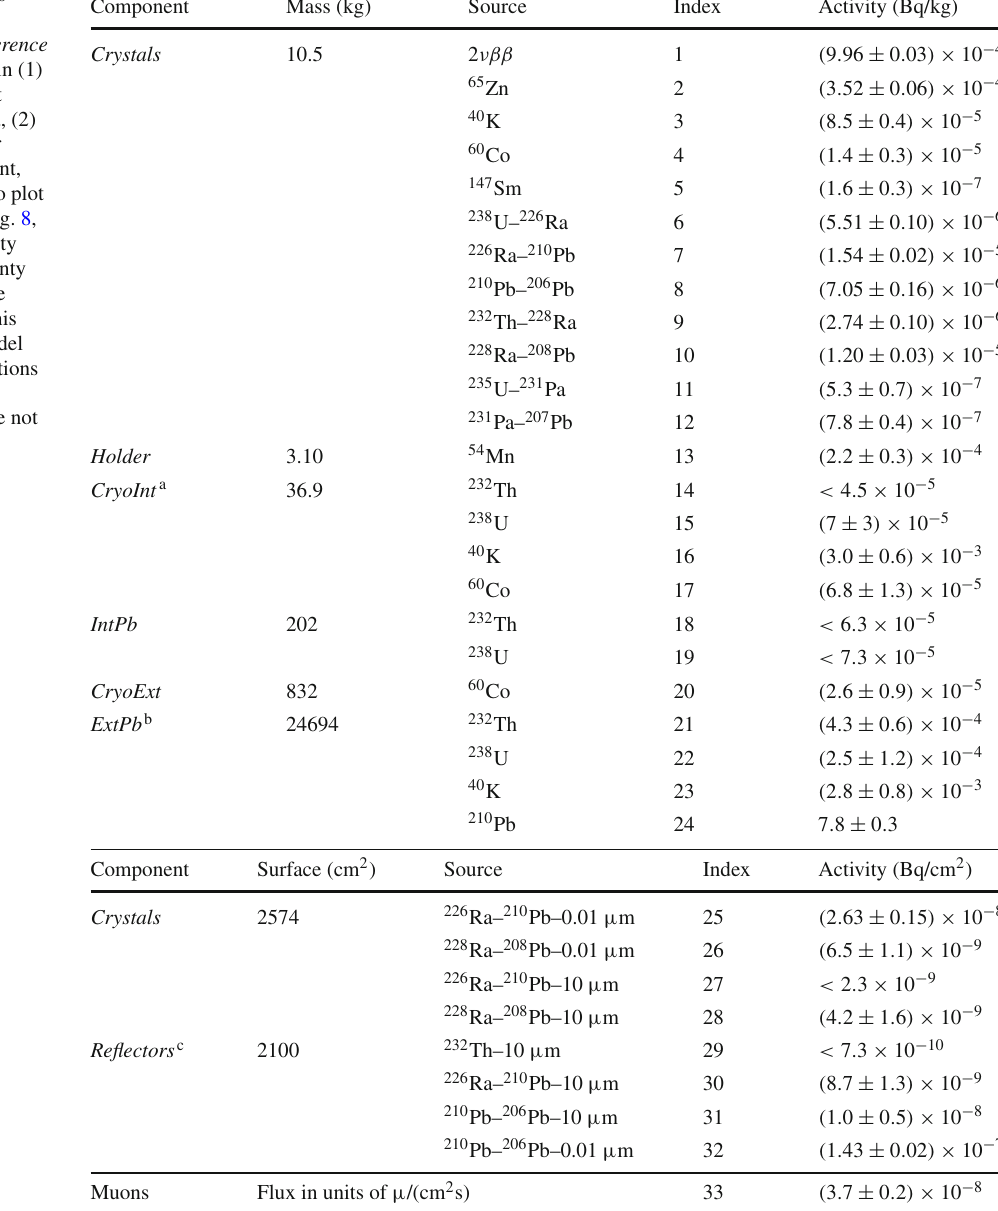
Table 4 List of the sources used to fit the CUPID-0 background data in the reference model. The columns contain (1) the name of the component where the source is located, (2) the corresponding mass (or surface), (3) the contaminant, (4) the source index used to plot the correlation matrix in Fig. 8, and (5) the evaluated activity with the statistical uncertainty (limits are at 90% CL). The source activities listed in this table are the result of a model involving some approximations and the corresponding systematic uncertainties are not included